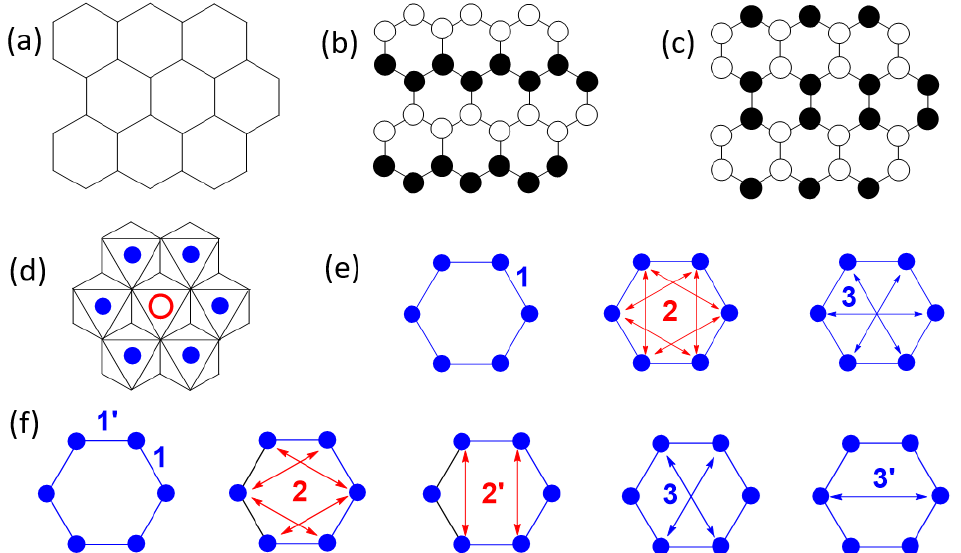
Figure 1. ( a ) A simplified view of a honeycomb layer made up of magnetic ions. ( b ) A zigzag order of magnetic moments in a honeycomb layer. ( c ) A stripy order of magnetic moments in a honeycomb layer. ( d ) A honeycomb layer of magnetic ions (solid blue circles) in which the center of every hexagon of magnetic ions is occupied by a cation (e.g., Na + in Na 2 IrO 3 , Sb 5+ in A 3 Ni 2 SbO 6 , Te 6+ in A 2 Ni 2 TeO 6 , (P-P) 8+ dimer in NiPS 3 ). ( e ) First NN spin exchange ( J 1 ), second NN spin exchange ( J 2 ), and third NN spin exchange ( J 3 ) in a honeycomb layer made up of regular hexagons of magnetic ions. ( f ) First NN spin exchange ( J 1 and J 1 ′), second NN spin exchange ( J 2 and J 2 ′), and third NN spin exchange ( J 3 and J 3 ′) in a honeycomb layer made up of slightly distorted hexagons of magnetic ions (e.g., 2-fold rotational symmetry).